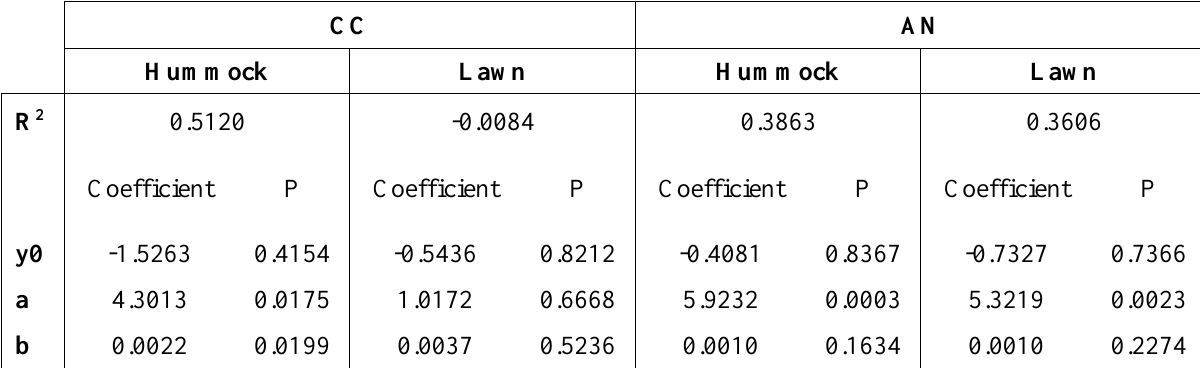
Table 3. Light response curve equation coefficients and adjusted R 2 for the Cayambe Coca (CC) and Antisana (AN) sites by microtopography (hummock and lawn). Note that AN values only included collars with 100 % vegetation cover. The equation fitted is exponential rise to the maximum, single, 3 parameter: f = y0 + a(1 - exp(-bx)). CC AN Hummock Lawn Hummock